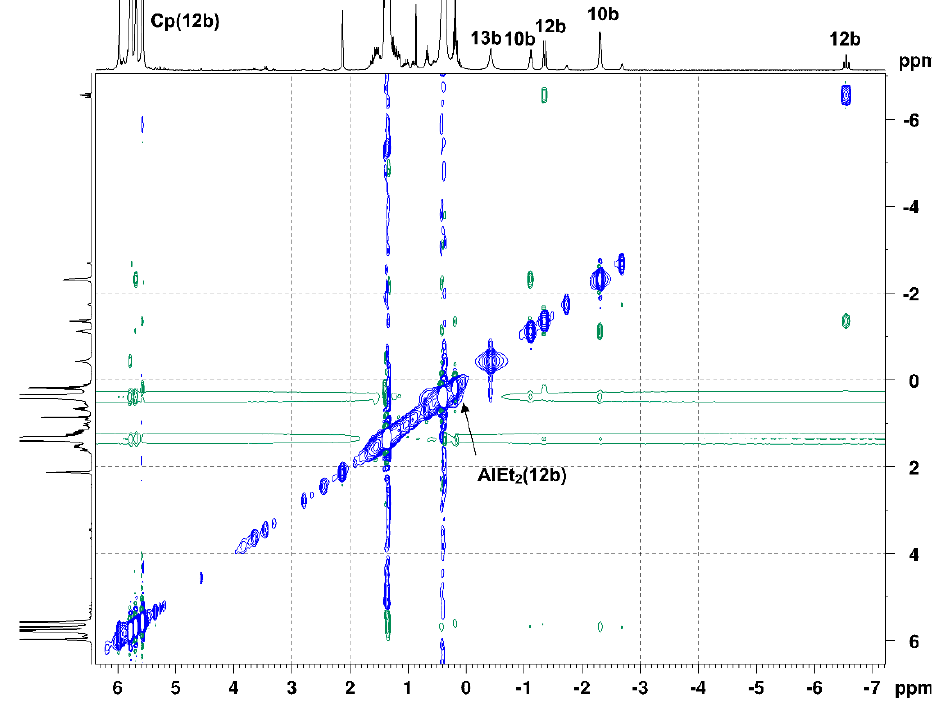
Figure 3. NOESY of [Cp 2 ZrH 2 ] 2 -ClAlEt 2 system (1:3) in С 7 D 8 .